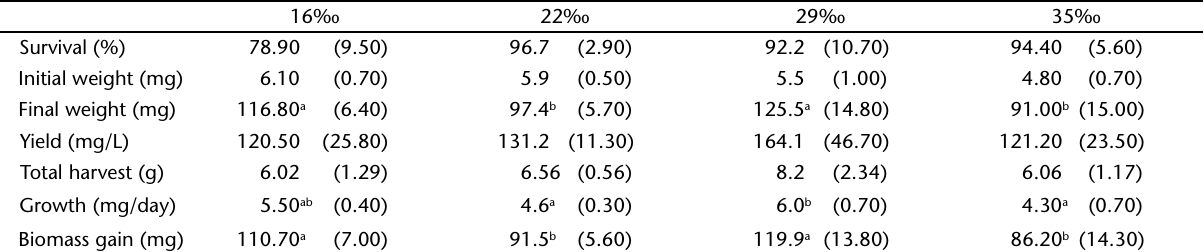
Table I. Nursery performance of F. paulensis postlarvae (PL 29, and 35‰) at 24.7 ± 1.6°C and 388 ind/m 2 . Results expressed as means (SD). Different superscript letters in the same row indicate significant differences (p < 0.05).